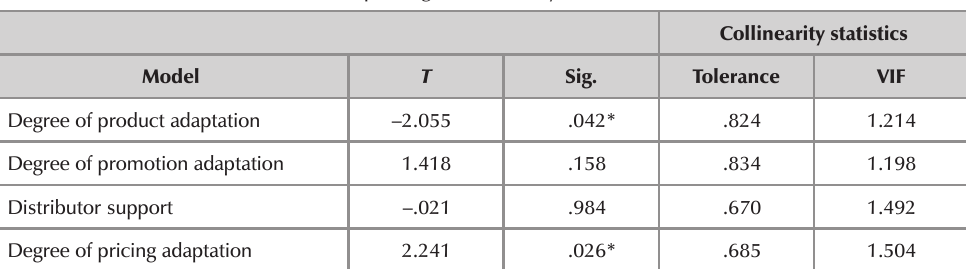
Multiple regression analysis